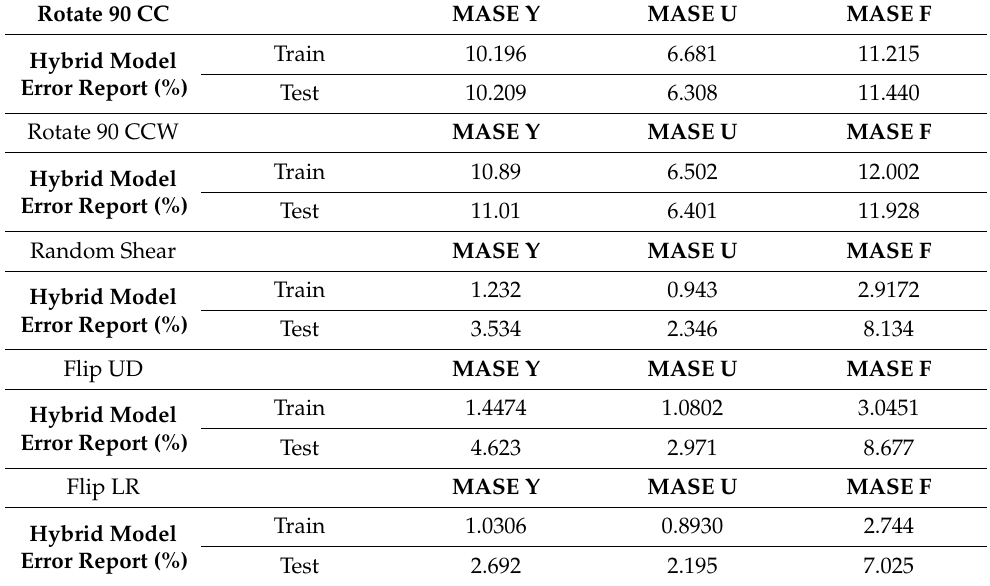
Table 6. MASE comparison for three labels of mechanical properties with different methods of traditional augmentation, such as flipping, rotating, and